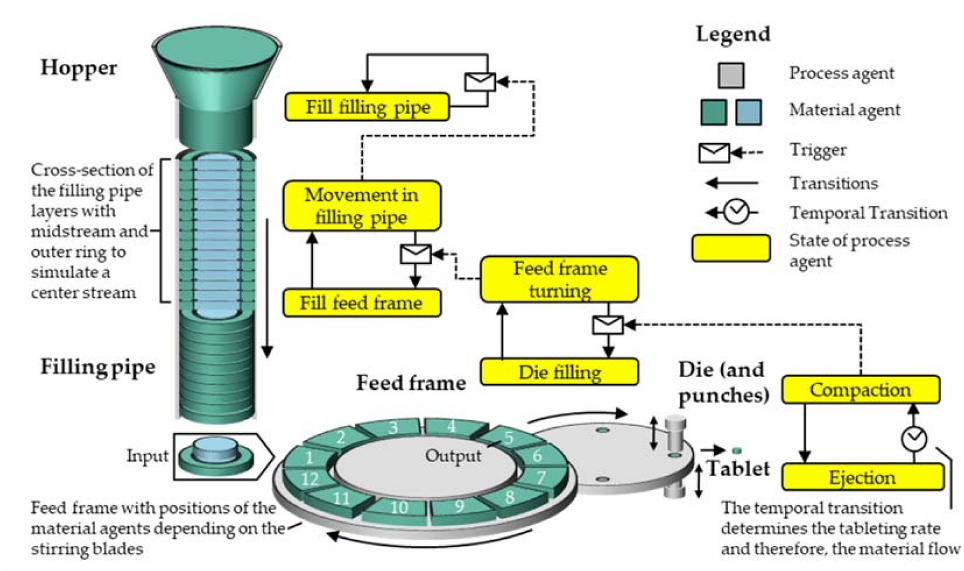
Figure 6. Schematic visualization of the process and material agents with the relevant states of the process